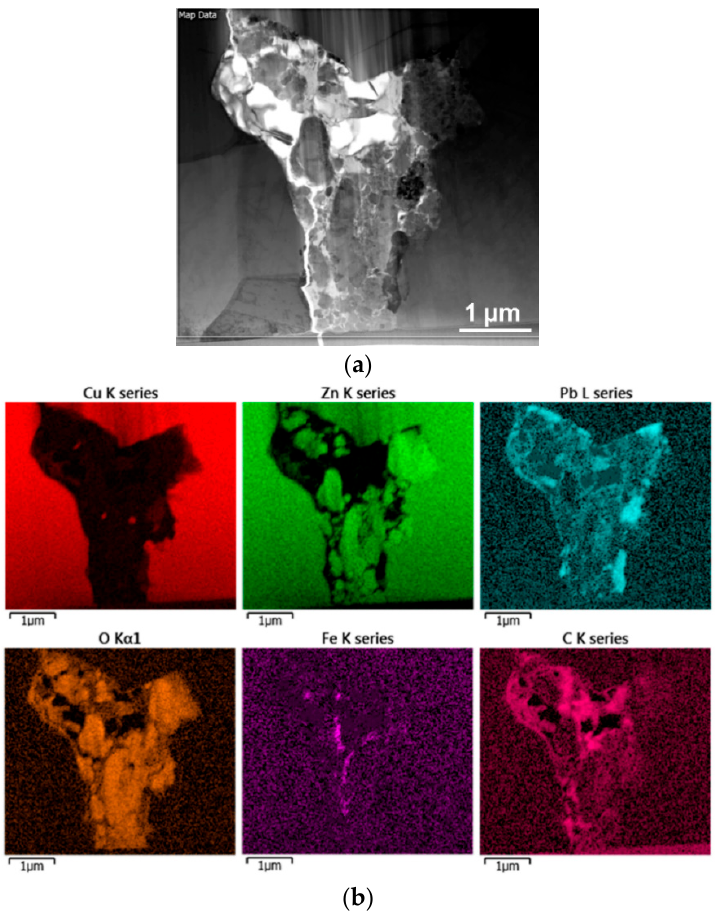
Figure 5. TEM scan (bright field) of the examined location with depicted area of EDS mapping ( a ); EDS maps for individual elements for the scanned area ( b ).